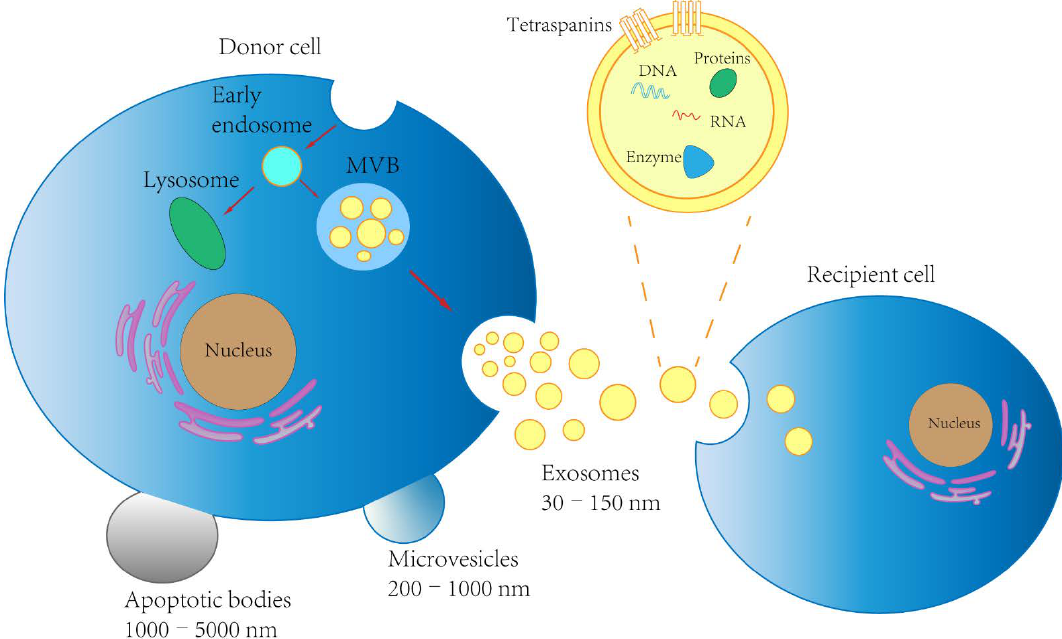
Figure 1. The biogenesis and content of exosomes. First, the plasma membrane depresses inward to form an early endosome, then multivesicular bodies (MVBs) are formed by the inward budding of endosomal membranes. Finally, exosomes are released by the fusion of MVBs with the plasma membrane.